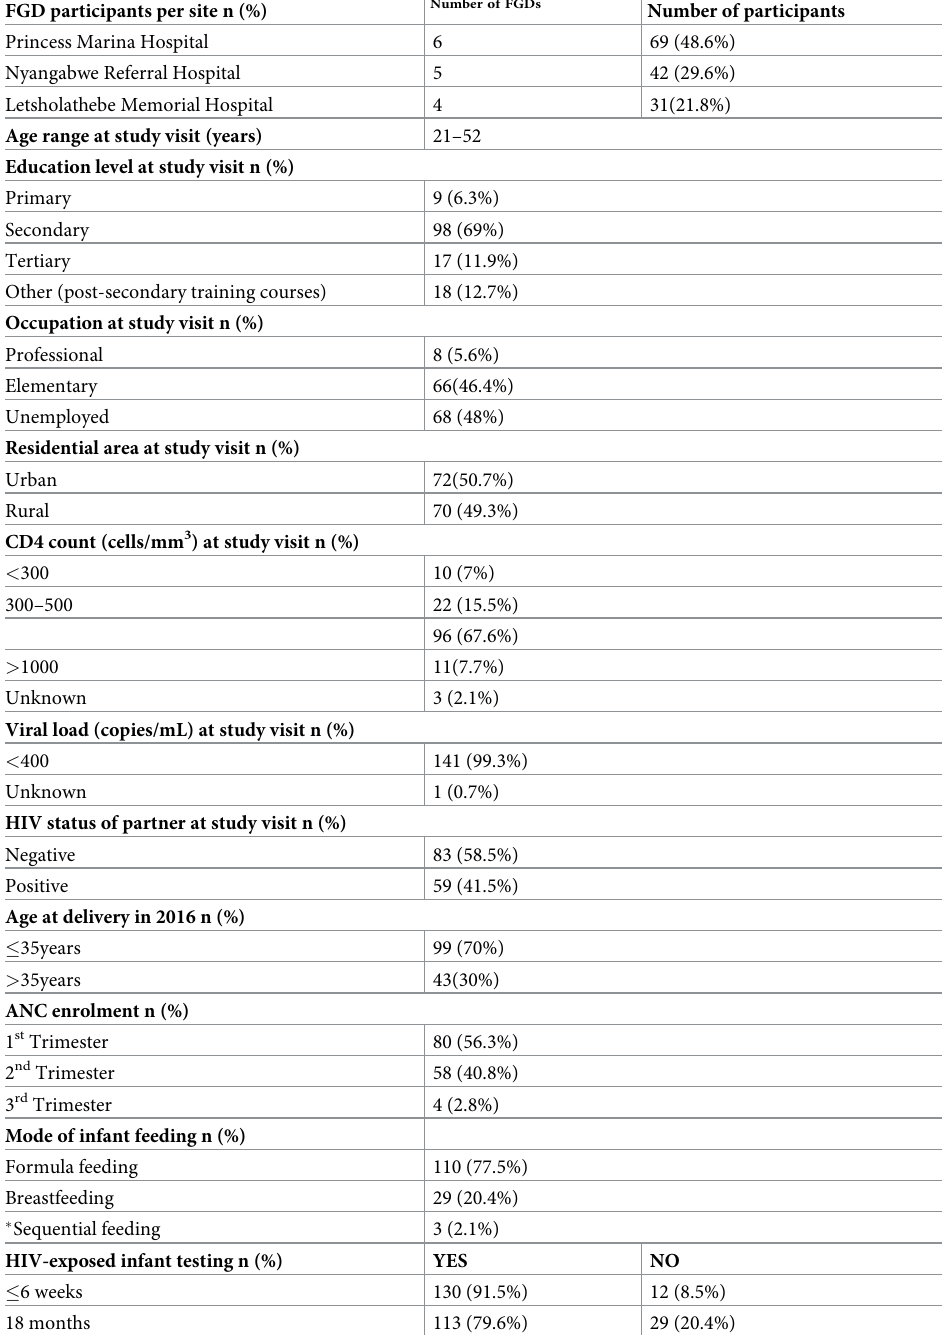
Table 1. Social-demographic and clinical characteristics of the sample (n =